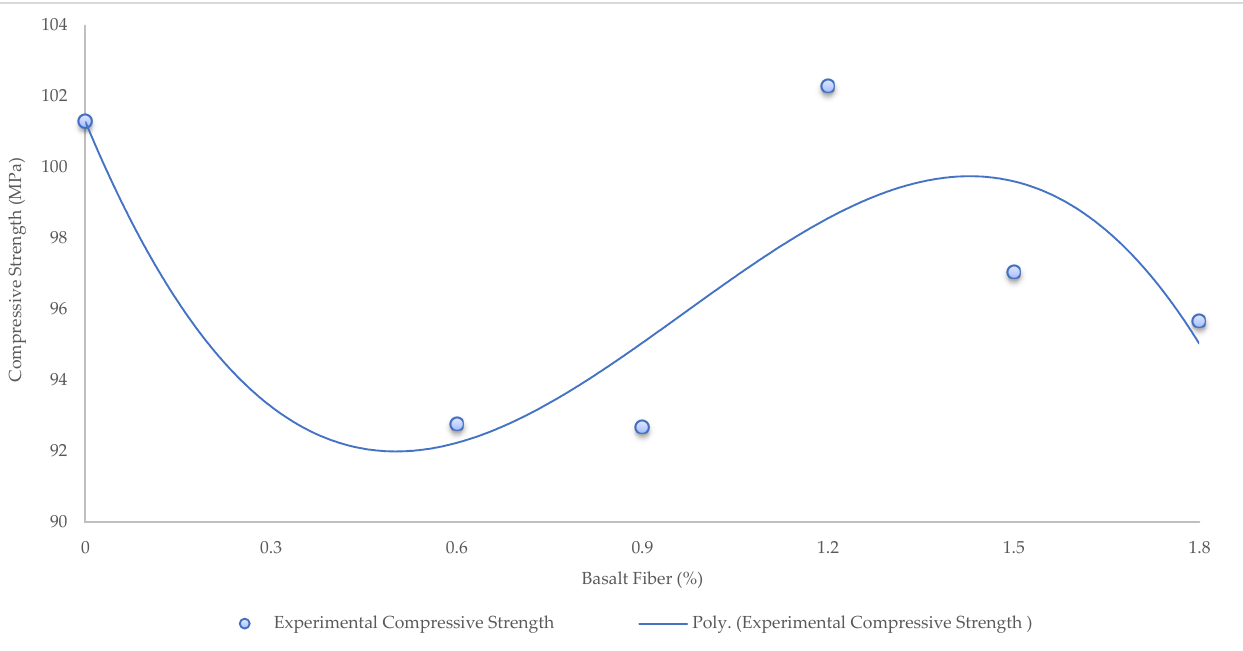
Figure 10. The relationship between BF percentages and compressive strength through Polynomial Function.